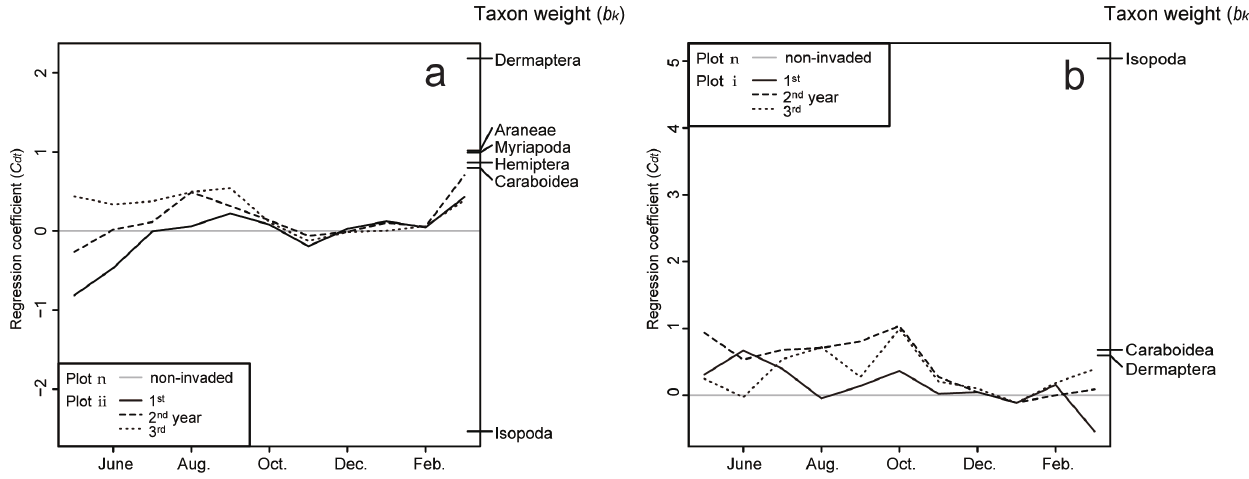
Fig 5. Principal response curve diagrams illustrating the shift of non-ant invertebrate communities over 3 years. (a) Plot ii, where no pesticide was applied after October 2013, and (b) Plot i, where no pesticide was applied after May 2012, relative to the control (untreated and non- invaded) plot over time. Left axis, regression coefficient; right axis, taxon weights (only taxa with a score of >0.5 or <−0.5 are shown). The first canonical axis explains 29.72% ( p < 0.001) of the total variation in Plot ii and 62.97% ( p < 0.001) in Plot i.